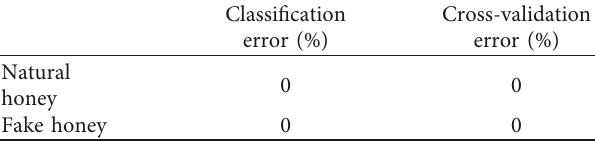
may be a promising method for the low-level adulteration of Table 3: LDA classification and cross-validation errors.